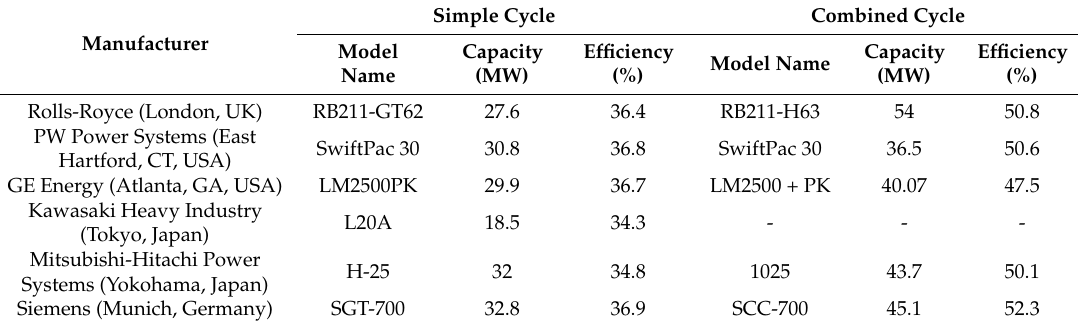
Table 1. Technical data of medium-sized commercial gas turbine models